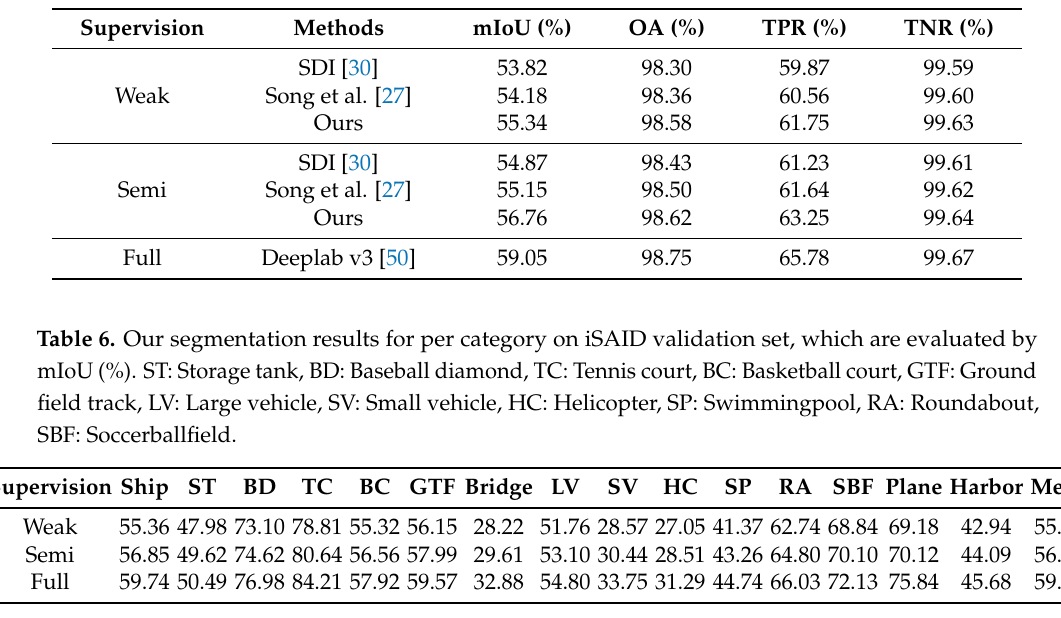
Table 5. Weakly supervised results on iSAID validation set.